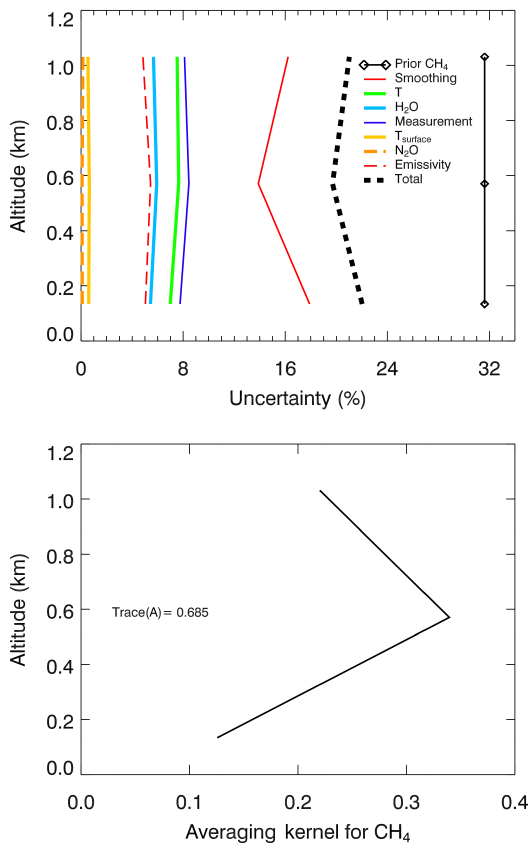
Figure 3. Error budget of the total error in retrieved CH 4 . The un- certainties of the a priori CH 4 (about 32%) drop to 20%, the total error after the